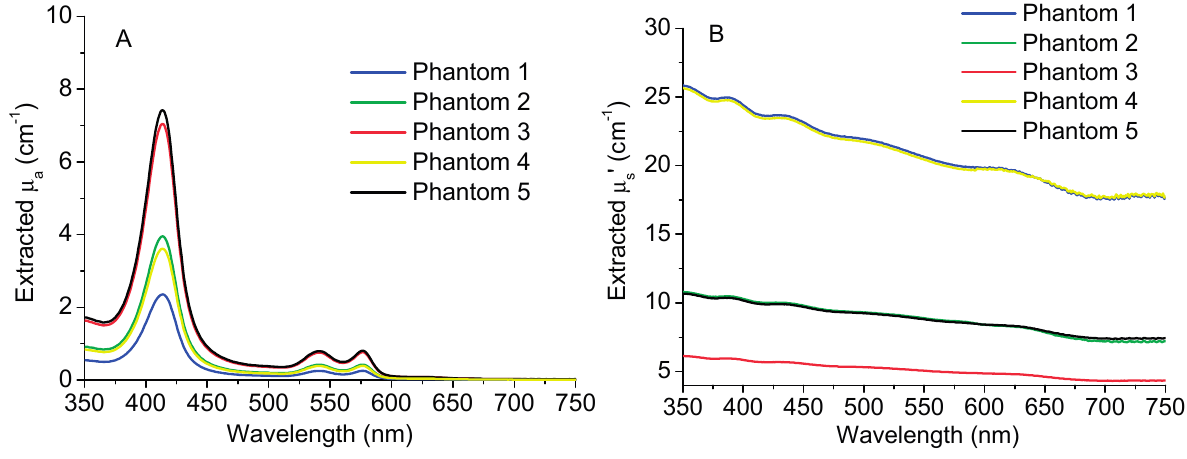
Figure 5. Extracted absorption ( A ) and reduced scattering ( B ) coefficients for all the test